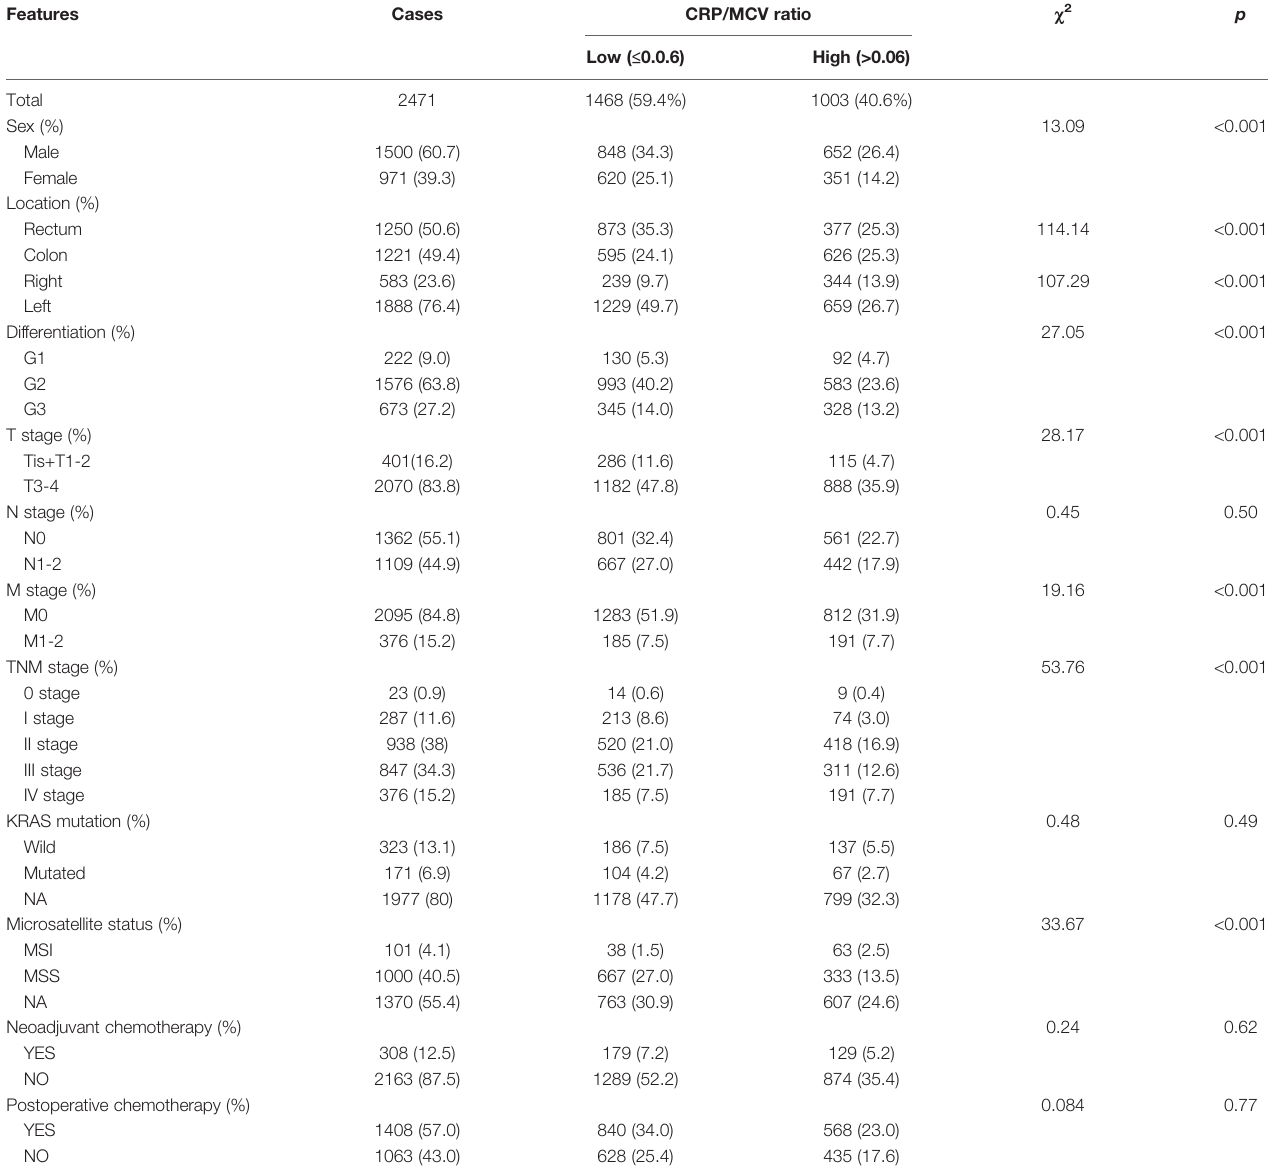
TABLE 1 | Baseline data based on CRP/MCV ratio categorical